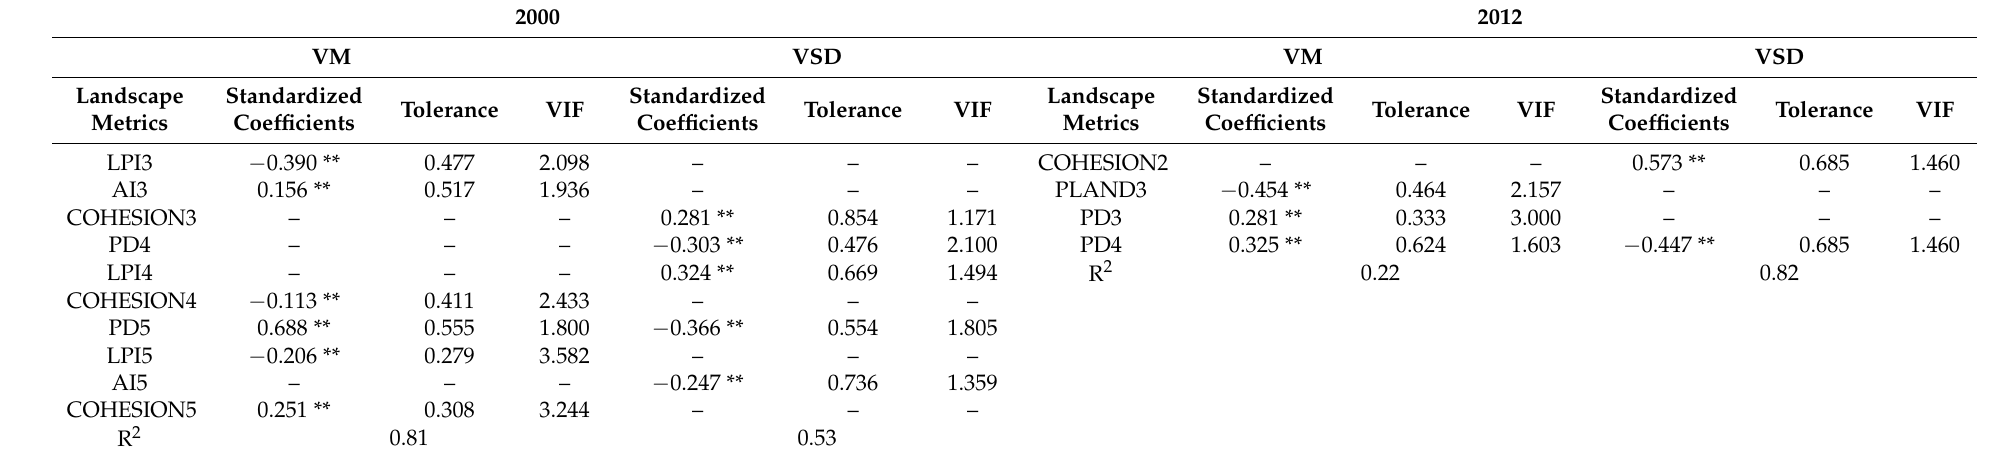
Table A3. SLR parameters of VM, VSD and class-level landscape metrics in industrial area.